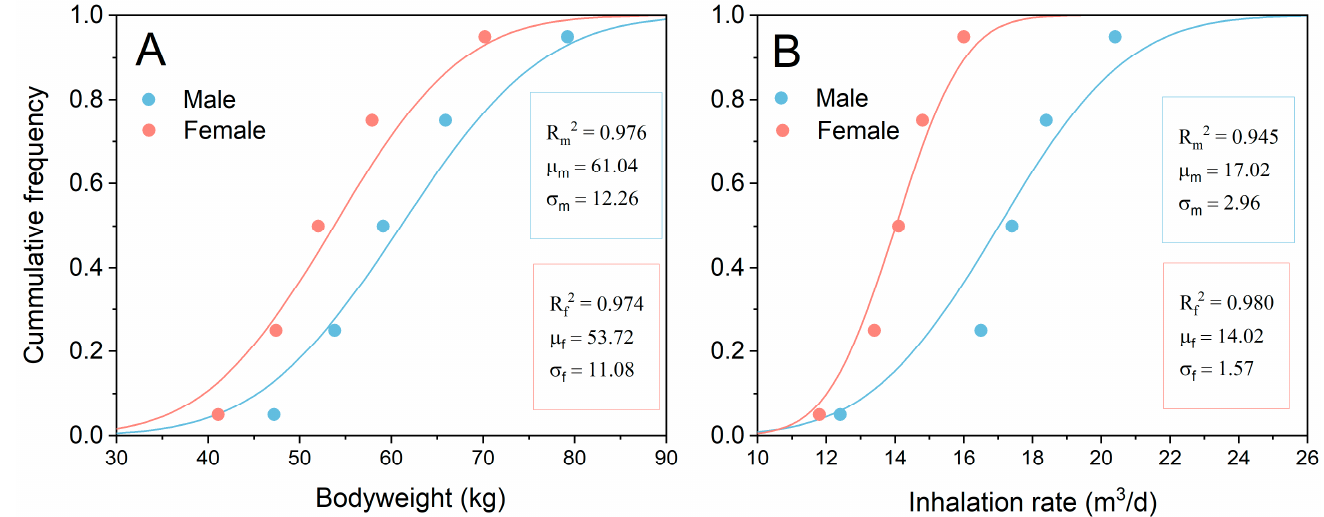
Figure 2. Fitting of bodyweight ( A ) and inhalation rate ( B ) of male and female population in Yunnan province. μ and σ are the arithmetic mean and standard variation of the normal distribution, respectively. Table 2. Parameters of risk assessment.